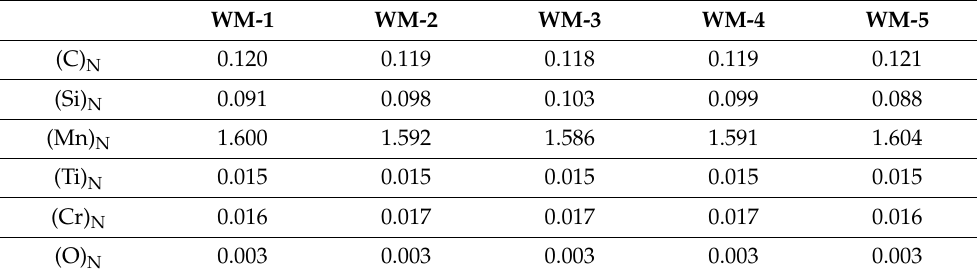
Table A2. The summary of metal nominal compositions (wt.%).